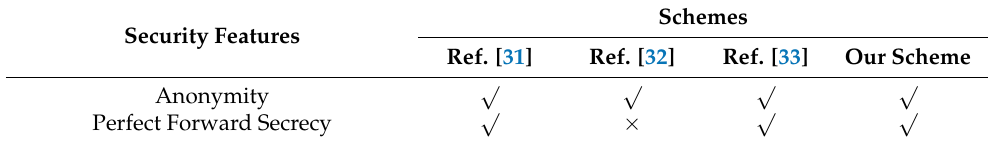
Table 9. Comparison of safety